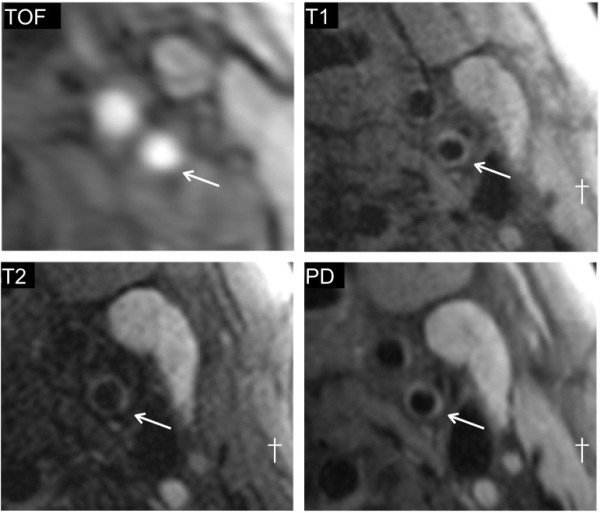
Example of restenosis due to possible myointimal hyperplasia. 65% restenosis of the left internal carotid artery 4 months following surgery is shown (*marks lumen, † marks sternocleidomastoid). The signal intensity seen from the arterial wall is comparable to that of the surrounding tissues on all four weightings.